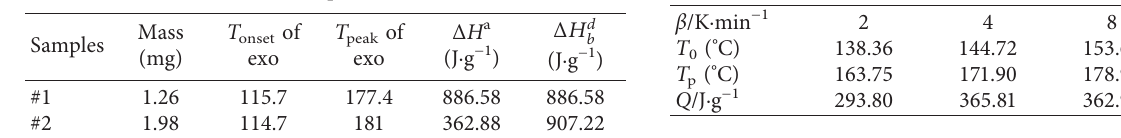
Figure 1: DSC curve of samples #1 and #2 at 8K · min − 1 . Table 3: DSC results of samples #1 and #2 at 8K · min − 1 .